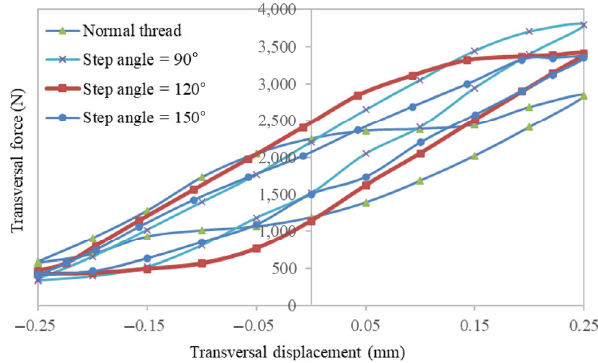
Fig. 14 Relationships between the transversal forces and transversal displacements in the normal bolt and novel bolts with different step threads.